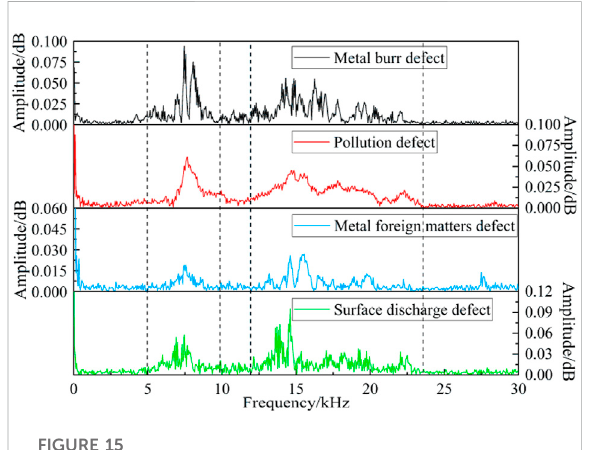
FIGURE 15 Spectral characteristics of the discharge audible signal.